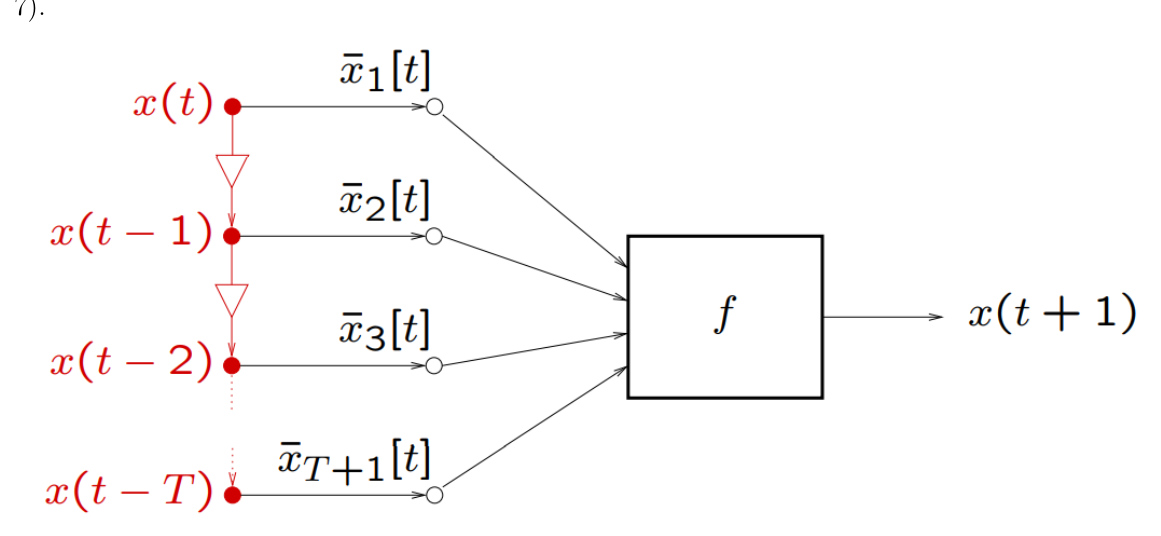
Fig. 2. Artificial neural networks & time series econometrics - digital SCM - convergence of tools